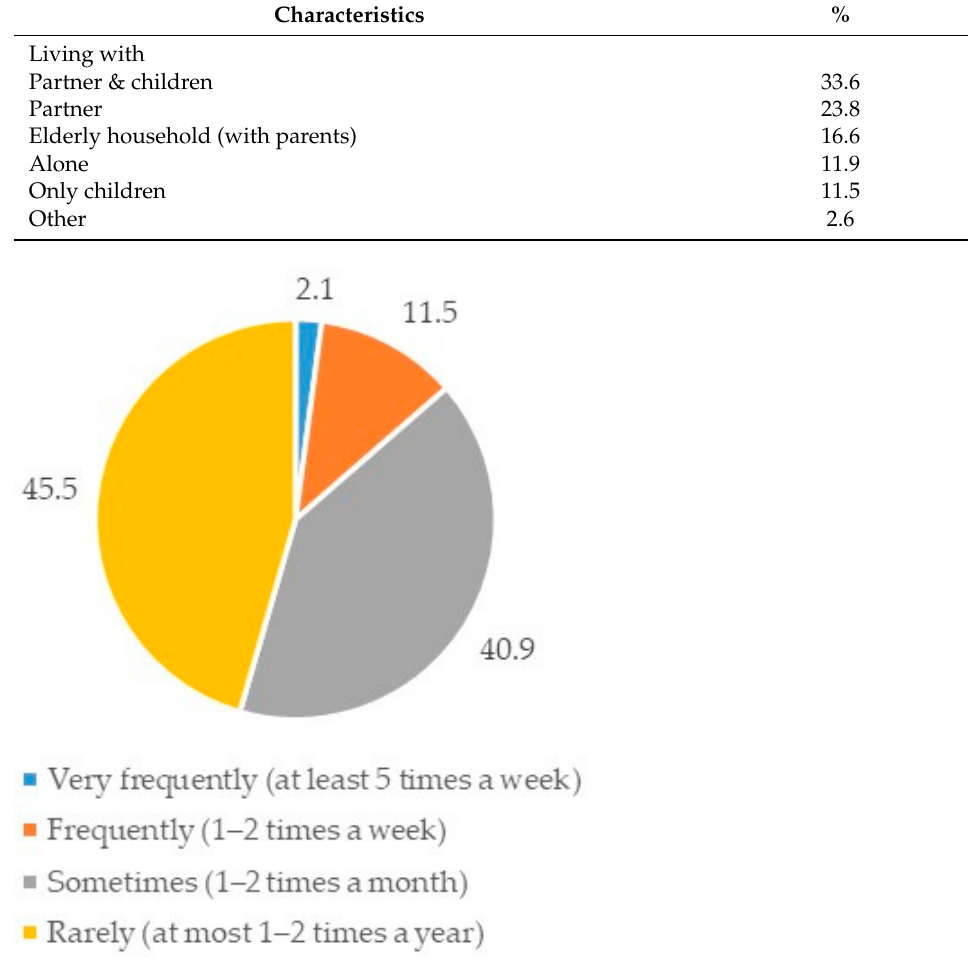
Figure 1. How often do you eat rabbit meat? (%, n = 705).